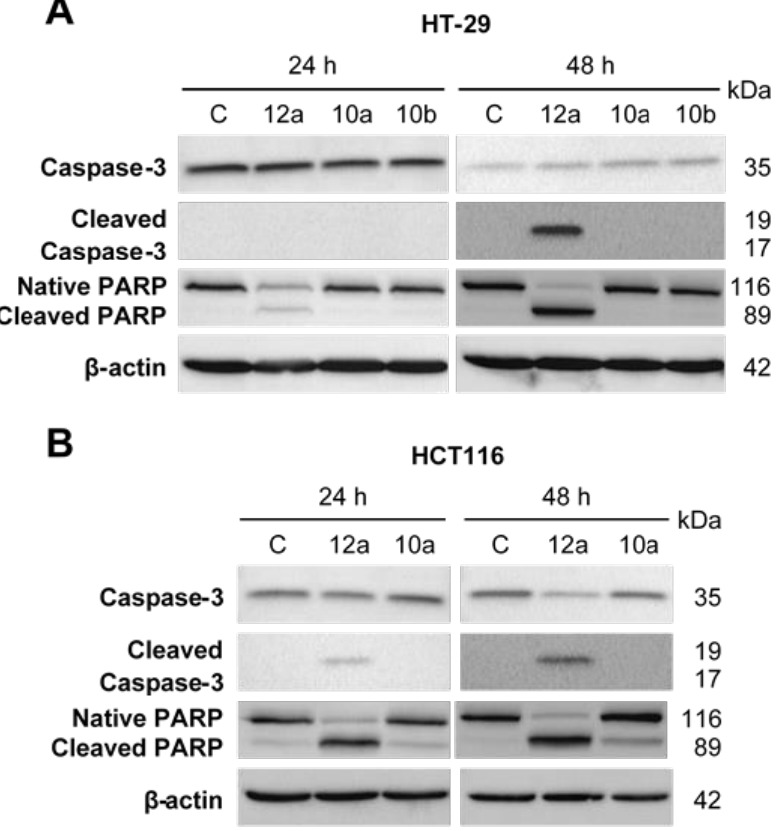
Figure 6. Effects of compounds 10a , 10b , 12a on apoptosis-related protein expression in human CRC HT-29 ( A ) and HCT116 ( B ) cells. β -actin was used as a loading control. Blots shown are representative of three separate experiments.